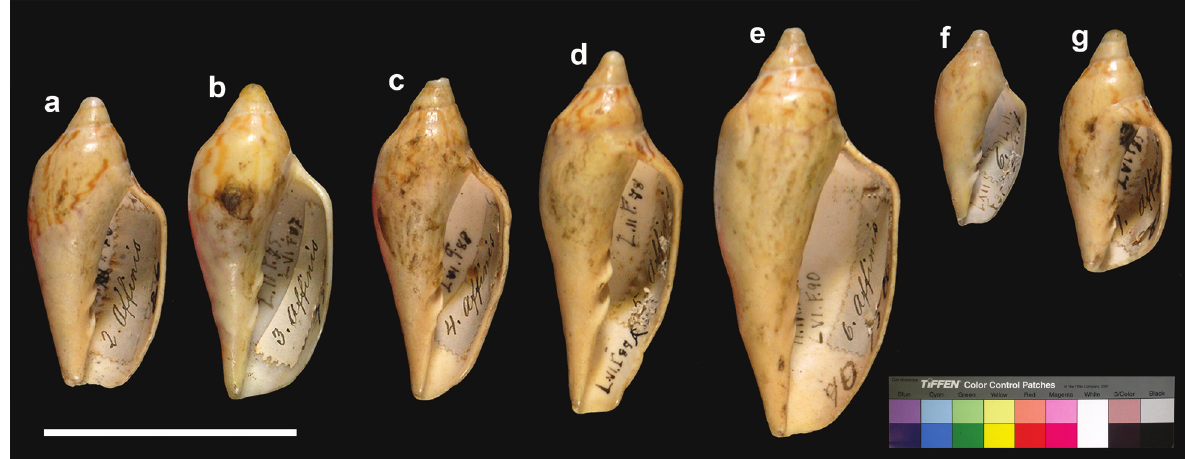
Figure 17. Voluta angulata affinis , specimens figured by Lahille (1895). See references on Table 5. Scale bar: 5 cm.